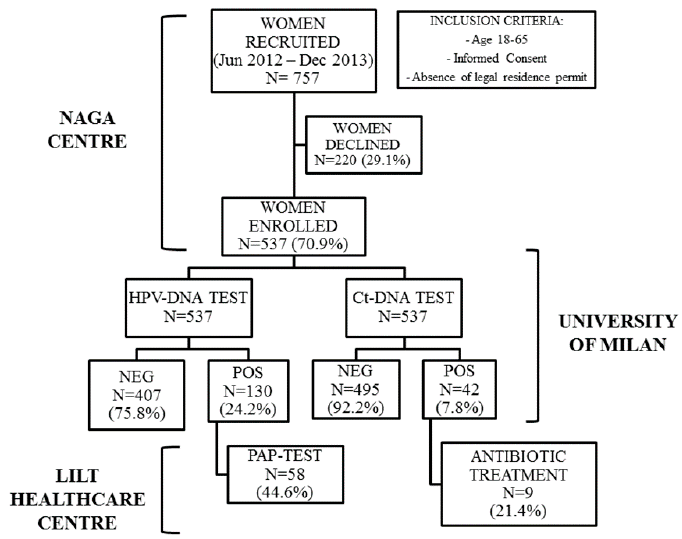
Figure 2. Flowchart with the study design and the main results.